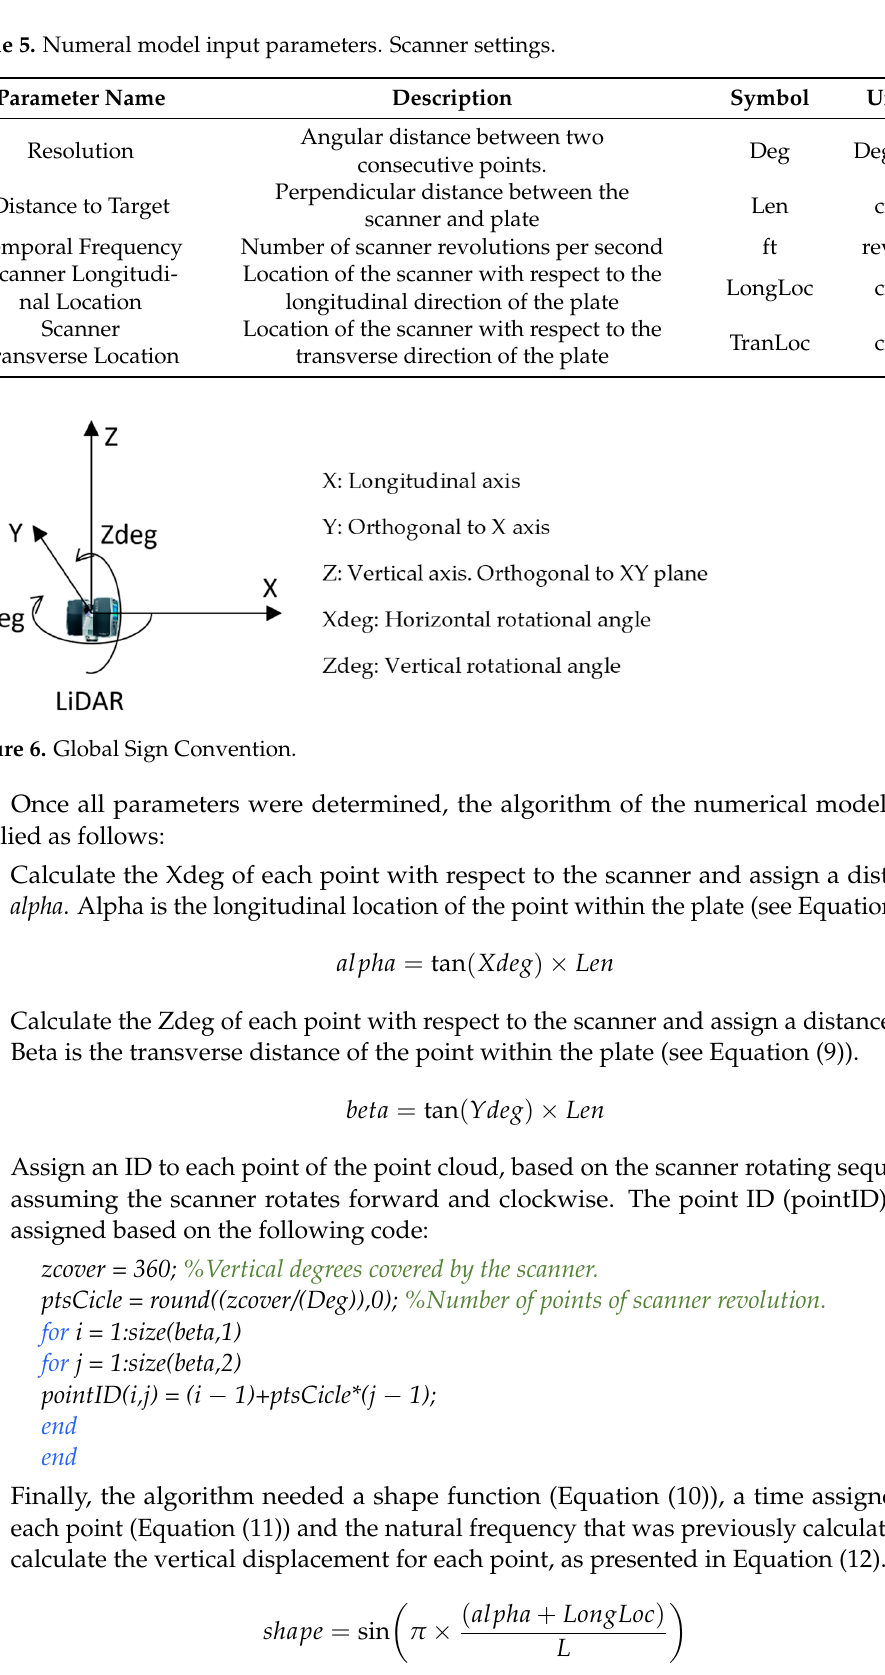
Table 5. Numeral model input parameters. Scanner settings.